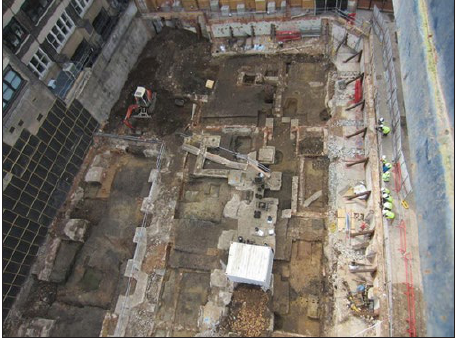
Figure 8: ASE site near the Aldwych, London (Photo: